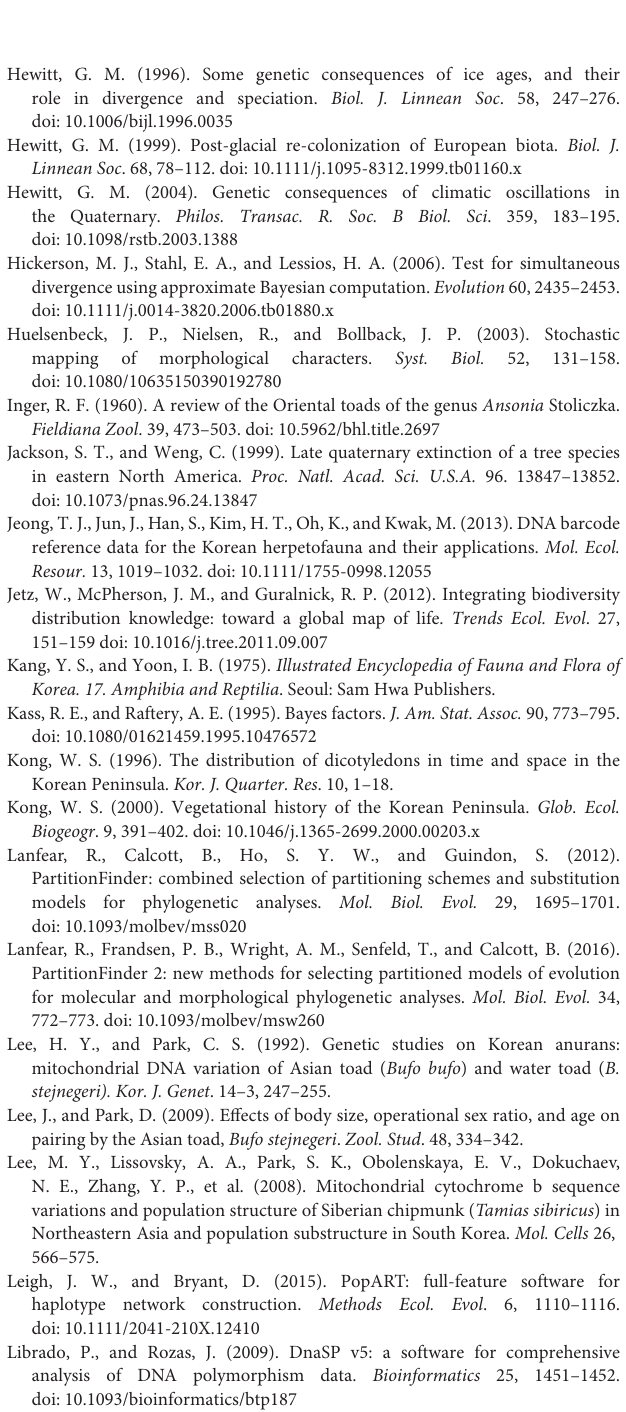
nodes represent the 95% confidence interval of the divergence date. Nodes with high support (posterior probability ≥ 0.95) are denoted with black, bold branches, while nodes with low support (posterior probability < 0.95) are denoted with red, thin branches. Table S1 | Primers used in this study. Table S2 | Geographic localities and GenBank numbers of new sequences used in this